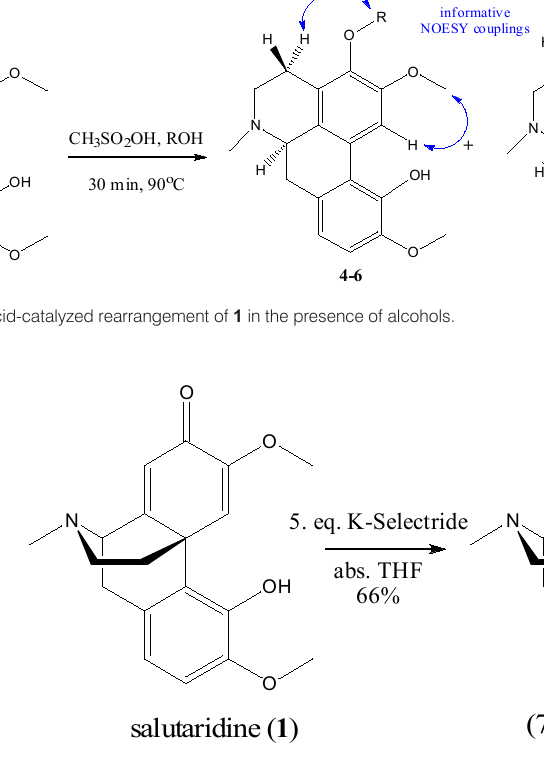
Scheme 5. Modified synthesis of 7S-salutaridinol ( 2 Table 1. Results of the corresponding rearrangement reactions of 1 in the presence of alcohols (ROH). ROH Isolated yields (%) *